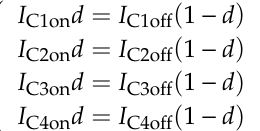
Figure 5. Curves of voltage gain versus duty cycle for two types of converters with input current ripple minimization.